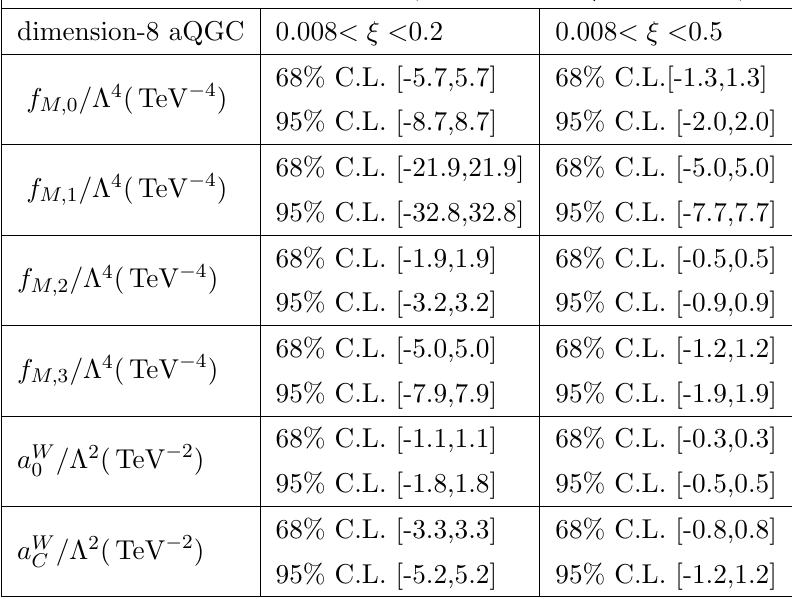
Table 7 . 68% and 95% C.L. expected limits on dimension-8 aQGCs assuming only one of them non-zero while the rest are set to zero. Expected limits on the dimension-6 aQGCs are also presented from translation of dimension-8 couplings. The limits include both acceptance scenarios and the 300 fb (cid:0) 1